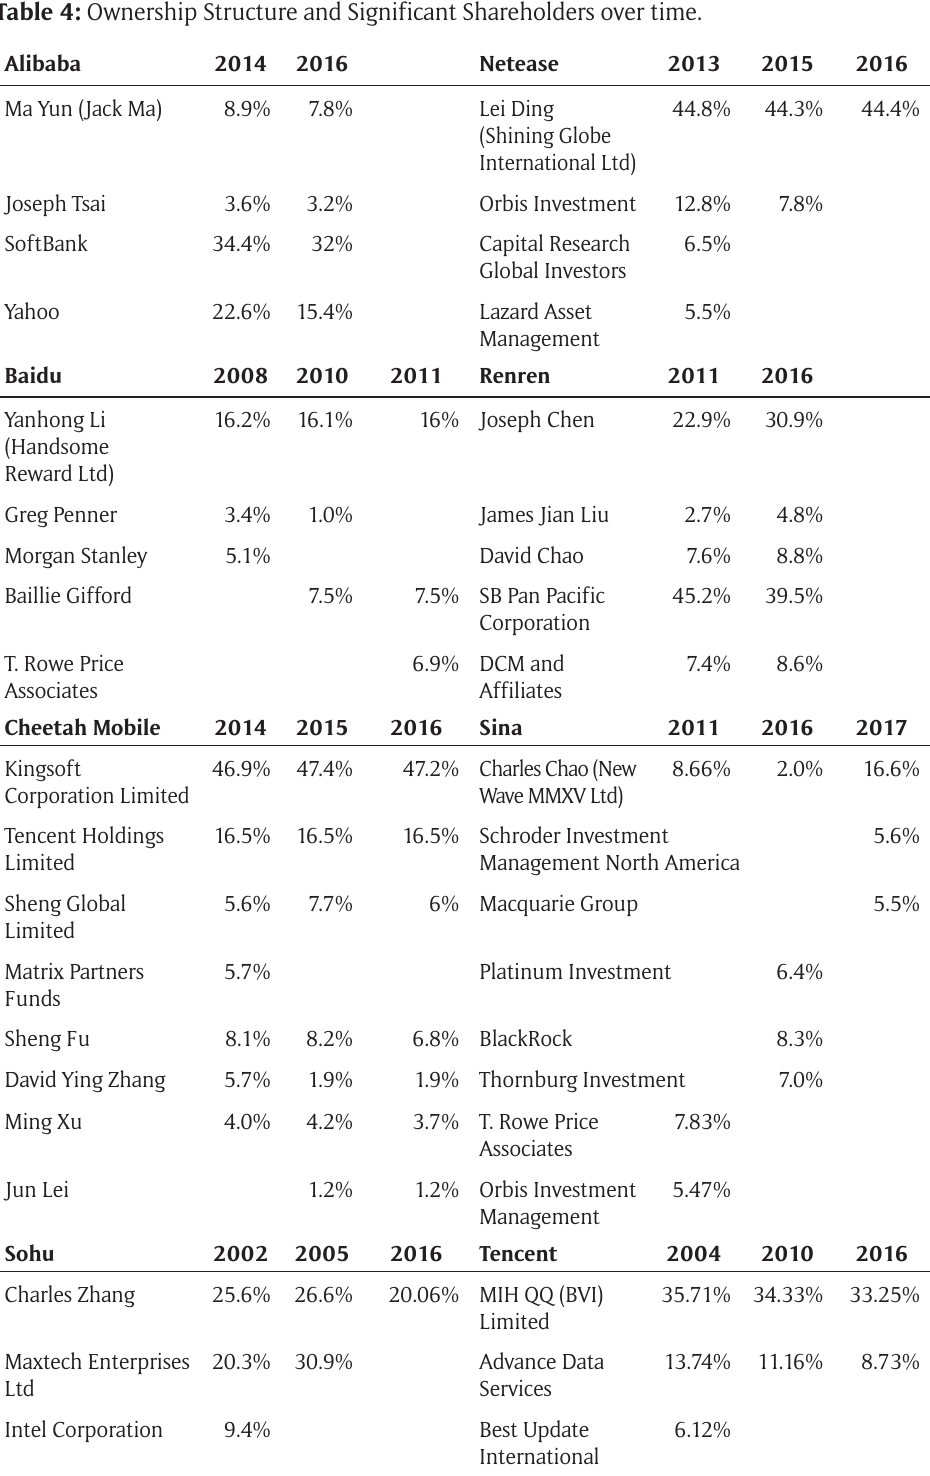
Table 4: Ownership Structure and Significant Shareholders over